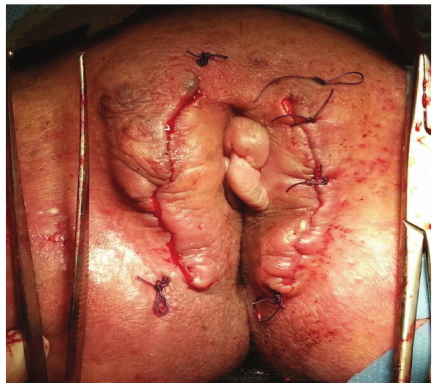
Figure 3: Labial masses were removed surgically.